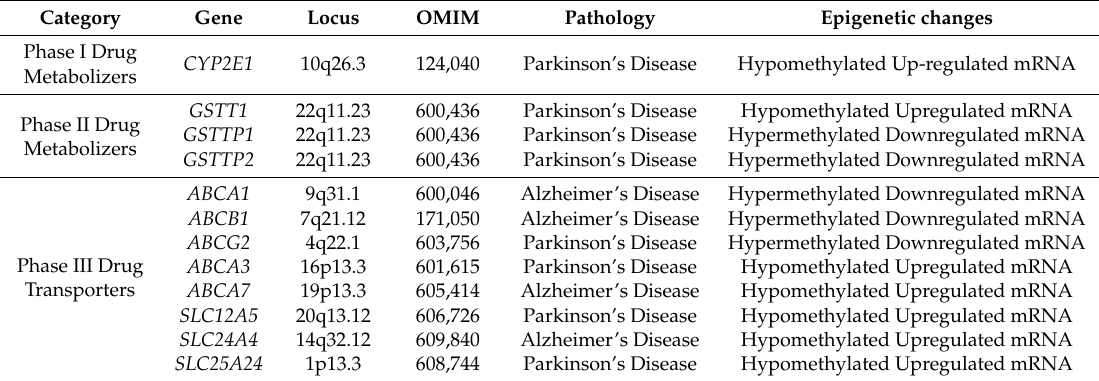
Table 2. Epigenetic modifications in genes involved in the pharmacogenomic response to drugs associated with the onset and/or progression of Alzheimer’s and Parkinson’s